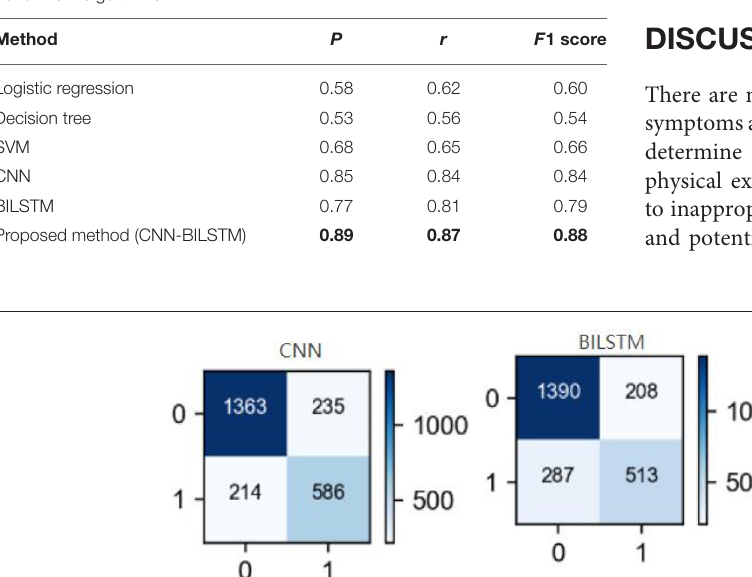
TABLE 1 | Performance comparison between the proposed method and multiple benchmark algorithms.